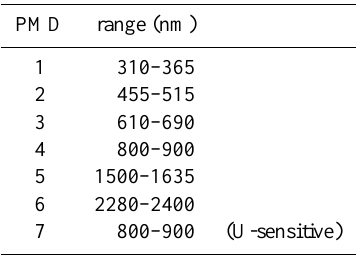
Table 1. Wavelength ranges of SCIAMACHY Polarisation Mea- surement